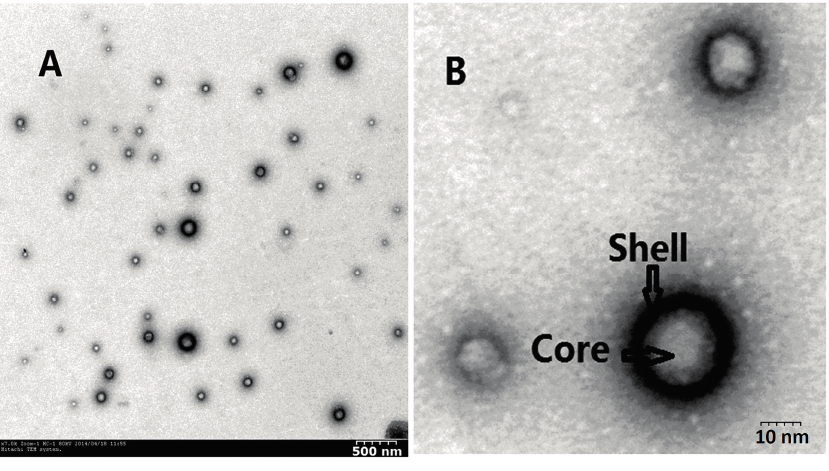
Figure 2. ( A ) Typical TEM images of Cur-lpNPs; ( B ) Expand TEM images of Cur-lpNPs.